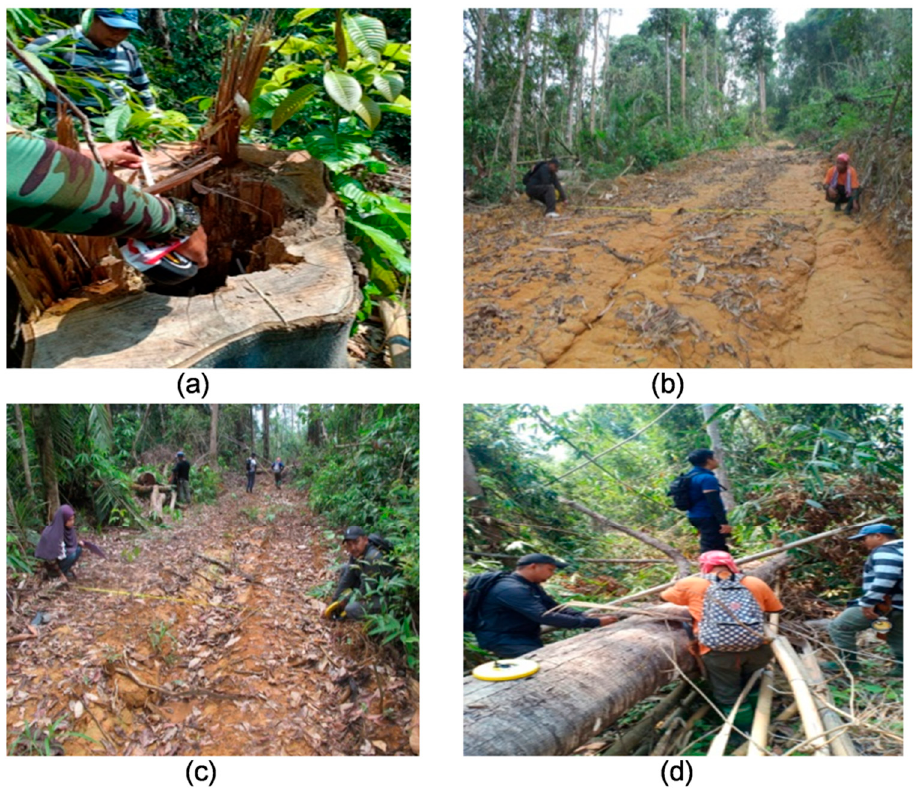
Figure 3. Example of the fieldwork methodology: ( a ) DBH measurement using tape diameter measured on tree stump; ( b ) measurement of length and width of logging roads; ( c ) measurement of length and width of skid trail; and ( d ) measurement of diameter, length and the cross-sectional areas of felled log.